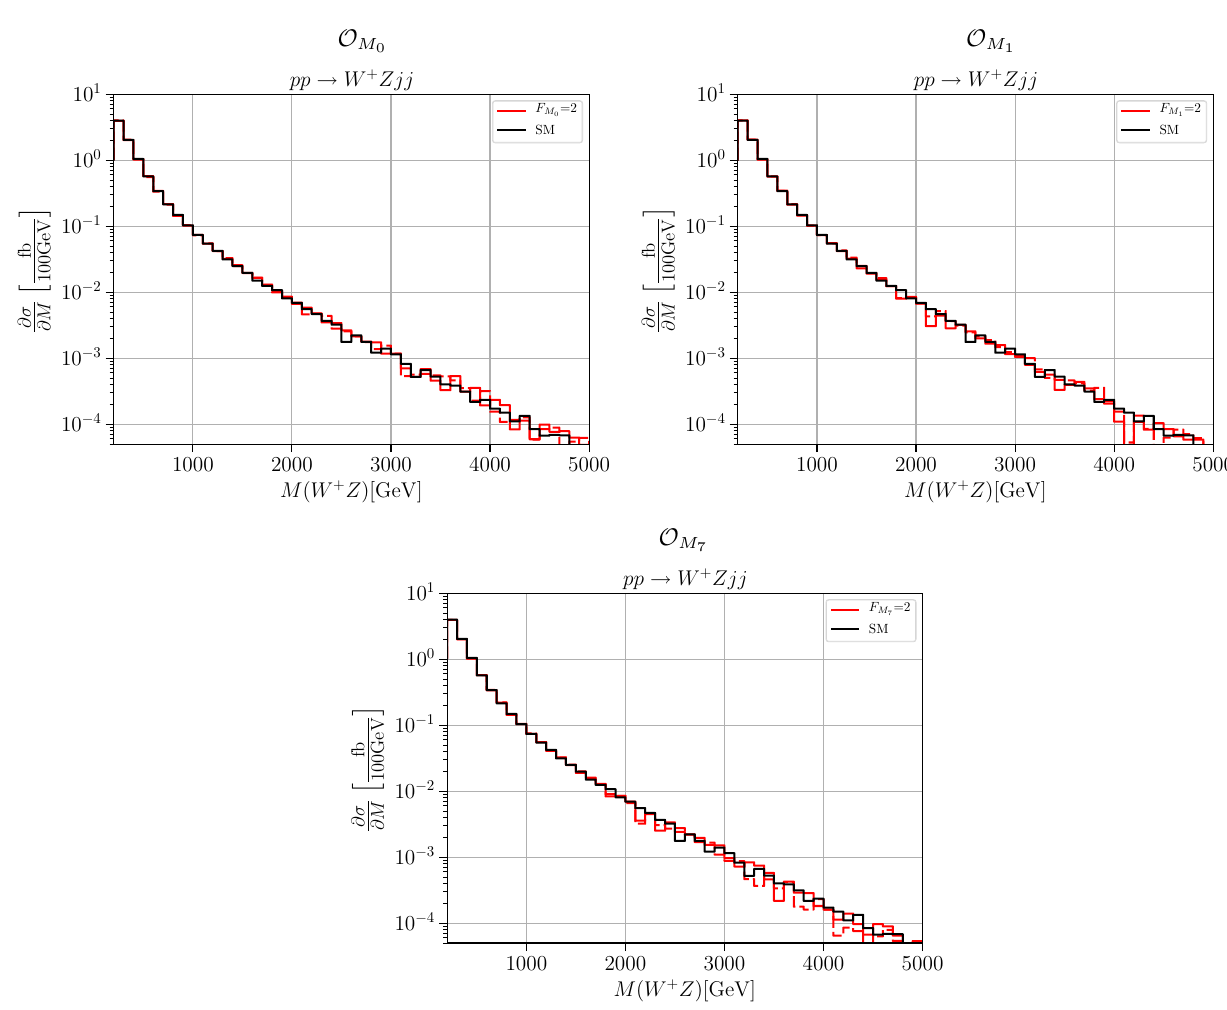
> 500 O M 0 , 1 , 7 (dashed: naive EFT, solid: unitarized model). Cuts: M jj > 20 GeV; | η | > 4 . GeV; Δη jj > 2 . 4; p j j T